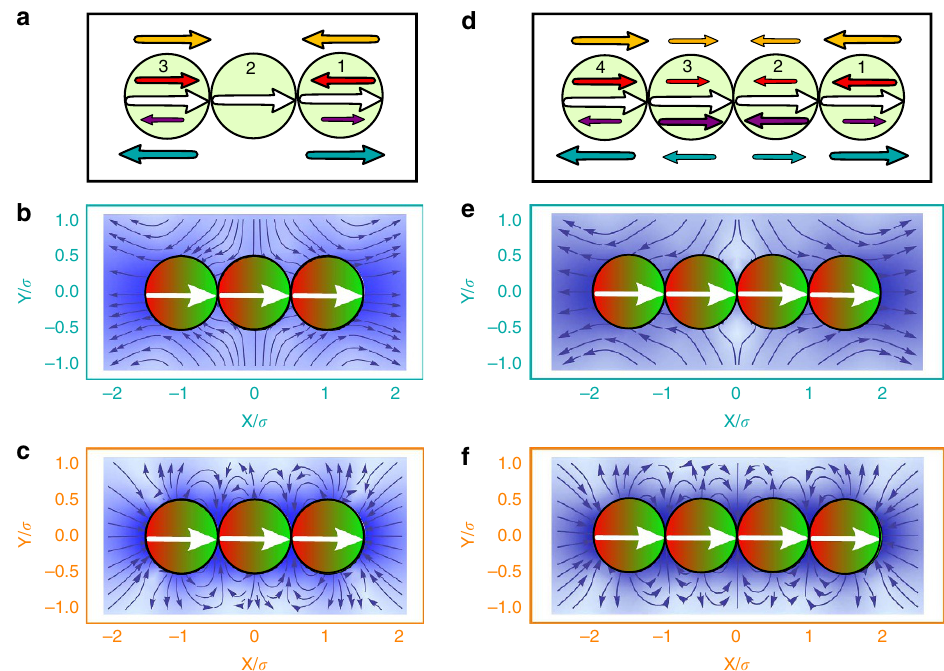
Figure 3 | Acting forces and flow field around chains. ( a , d ) Acting forces in a chain of N ¼ 3 and N ¼ 4 microswimmers. The arrows indicate direction and magnitude of all acting forces: self-propulsion force (white), force due to magnetic dipole–dipole interaction (red) and the basic HI due to the Stokeslet (purple). In case of pushers, the extensile flow leads to an repulsion (cyan) and in case of pullers the contractile flow leads to an attraction (orange arrows). Resulting flow field for a linear chain of ( b ) N ¼ 3 and ( e ) N ¼ 4 pushers as well as for ( c ) N ¼ 3 and ( f ) N ¼ 4 pullers using the same colour coding as